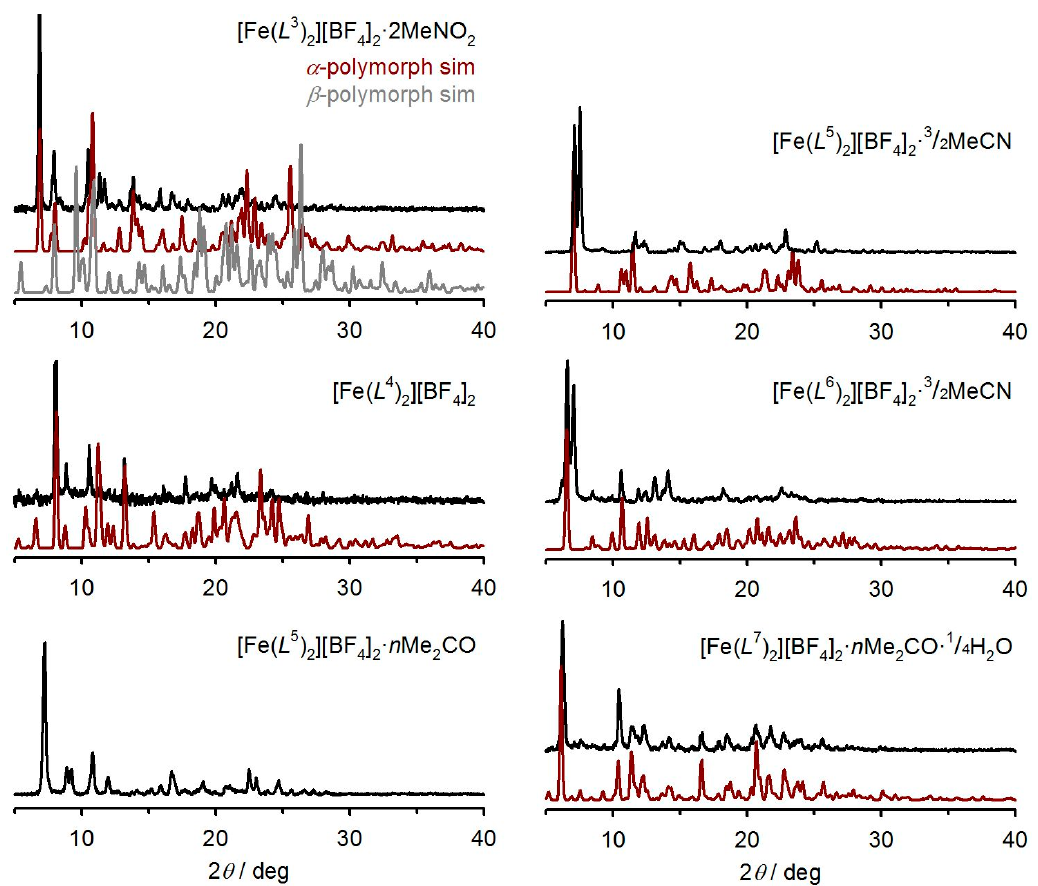
Figure 5. Measured (black) and simulated (red, grey) X-Ray powder diffraction data from the